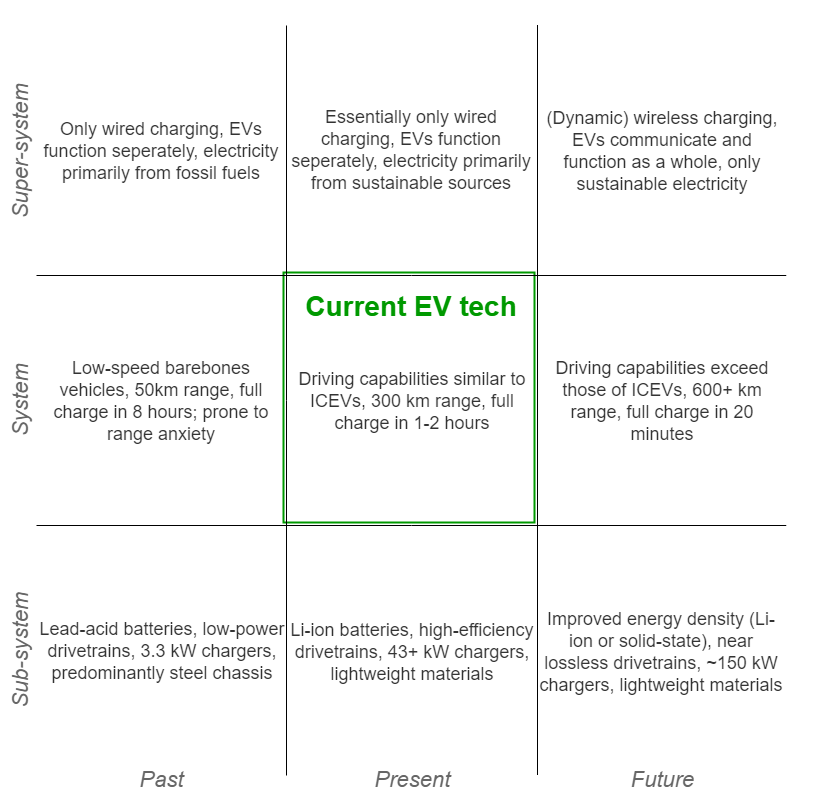
Figure 1. Nine-window diagram placing EV technology in its temporal and hierarchical context, showing particular elements that change over time and affect EV capabilities. Developed from the model in